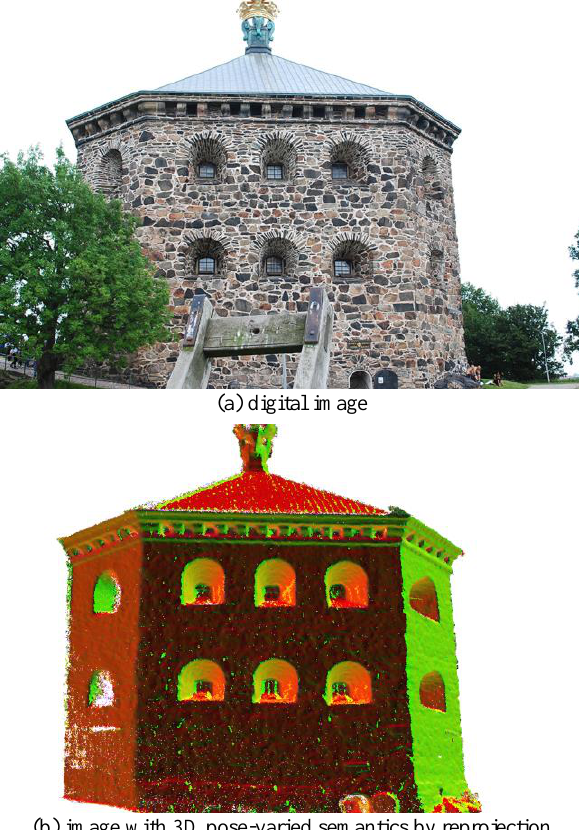
Figure 8 . Image with multi-modal semantic